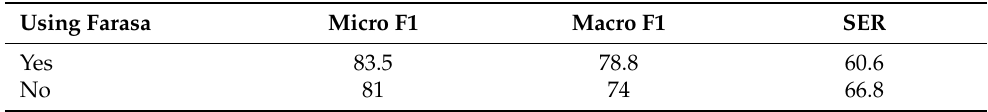
Table 12. Evaluation of TunedAraBERT: Micro, Macro F1, and sanad error rate on the test set with/without Farasa segmenter.